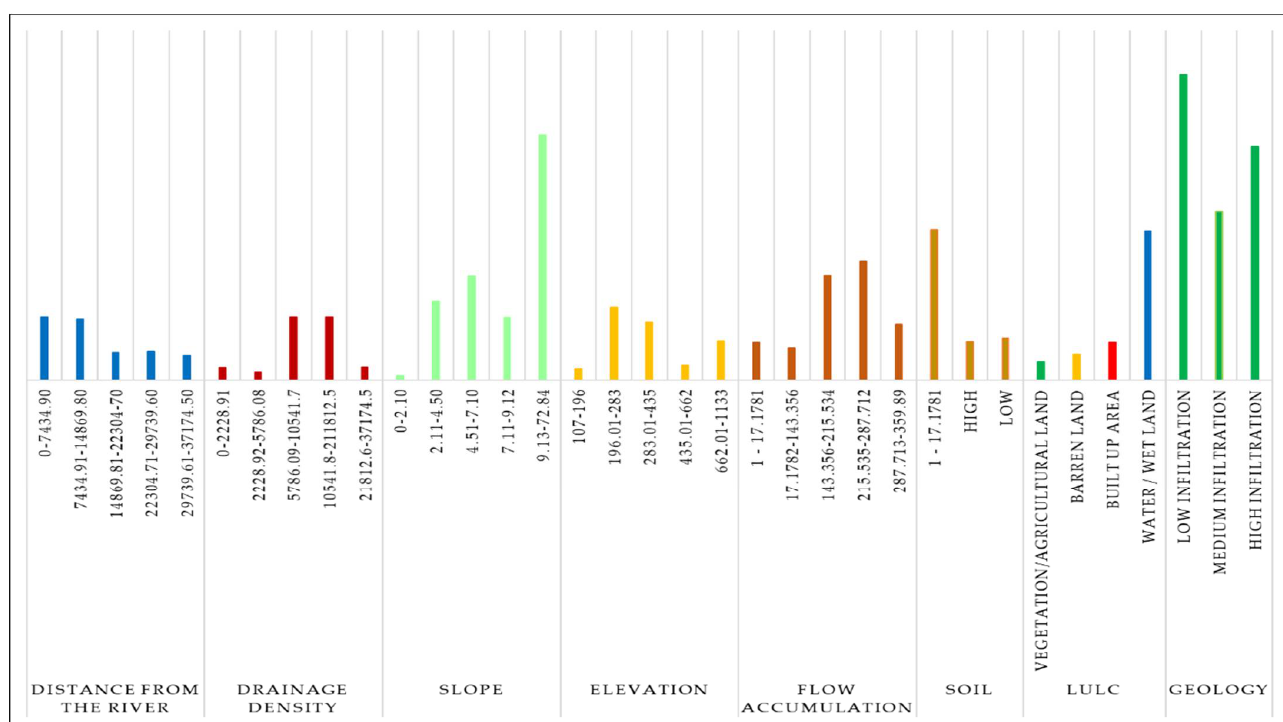
Figure 5 . Flood-inducing factors for mapping flood susceptibility based on class frequency ratios. Table 3. The flood-causing factors and their chosen factor weight values (SFWVs) are presented in the flood susceptibility mapping only for clarification.